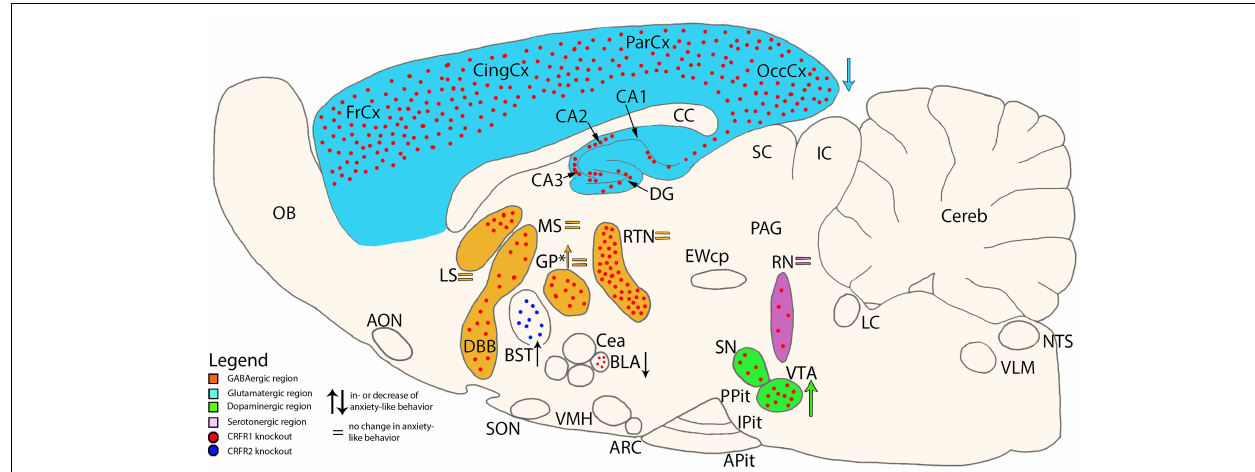
FIGURE 2 | Schematic cross-section of the mouse brain showing site specific knockouts of either CRF receptor 1 or 2 and the associated neurotransmitter specificity. Colored arrows show the direction of change on anxiety-like behavior in mice which lack CRFR1 in specific brain areas (Refojo et al., 2011). *In one study, CRFR1 was deleted in only the GP (Sztainberg et al., 2011), while in another study CRFR1 was deleted in all areas expressing GABA (Refojo et al., 2011). Other areas of interest are the basolateral Amygdala (BLA) (Sztainberg et al., 2010) and Bed nucleus of the StriaTerminalis (BST) (Lebow et al., 2012). AON, anterior olfactory nucleus; Apit, anterior pituitary; ARC, arcuate nucleus; BLA, basolateral amygdala; BST, bed nucleus of the stria terminalis; CA1-3, fields CA1-3